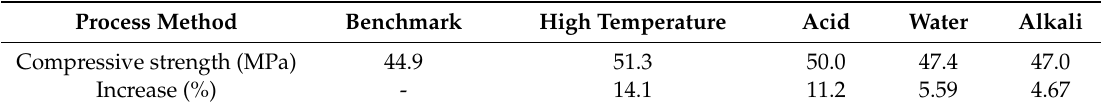
Table 4. The comparisons of the compressive strength for benchmark and di ff erent processes carbon-fiber-reinforced cement specimens.